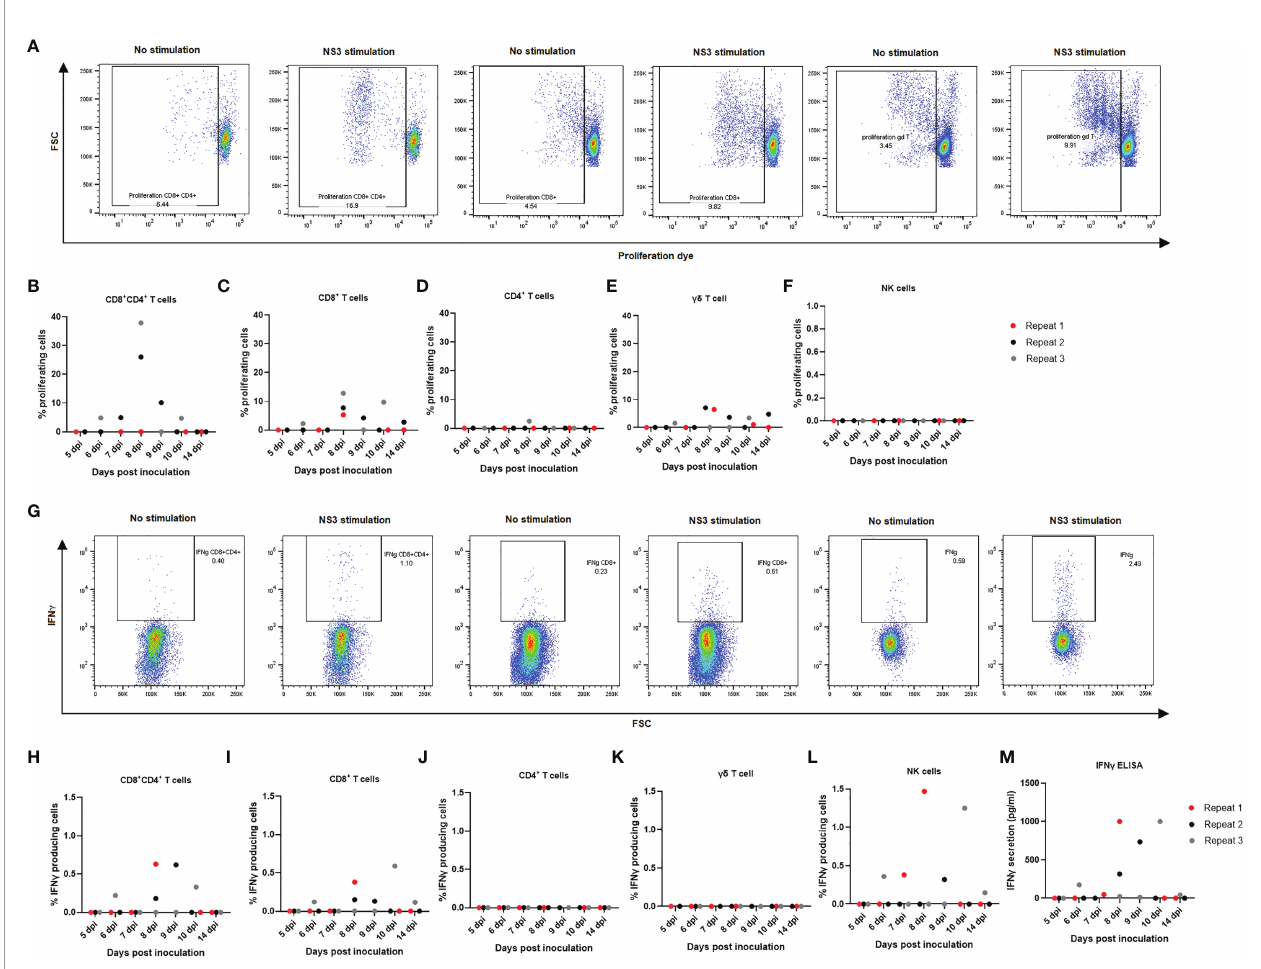
FIGURE 5 | Detection of cell-mediated immune responses after in vitro stimulation of PBMCs from JEV-infected pigs with NS3 antigen. Isolated PBMCs from three 9-week-old pigs per time point were left to proliferate for 4 days in the presence of NS3 antigen. (A) Flow cytometry analysis of proliferation for (B) CD4 + CD8 + double-positive T cells, (C) CD8 + T cells, (D) CD4 + T cells, (E) gd T cells, and (F) NK cells. Each dot represents one animal. Isolated PBMCs were incubated for 18 h in the presence of the NS3 pepmix and IL18 before adding BFA for the fi nal 6 h. (G) Flow cytometry analysis of IFN g production for (H) CD4 + CD8 + double-positive T cells, (I) CD8 + T cells, (J) CD4 + T cells, (K) gd T cells, and (L) NK cells. One dot represents one animal. (M) These results were con fi rmed with an IFN g ELISA after 24 h of stimulation of isolated PBMCs in the presence of NS3